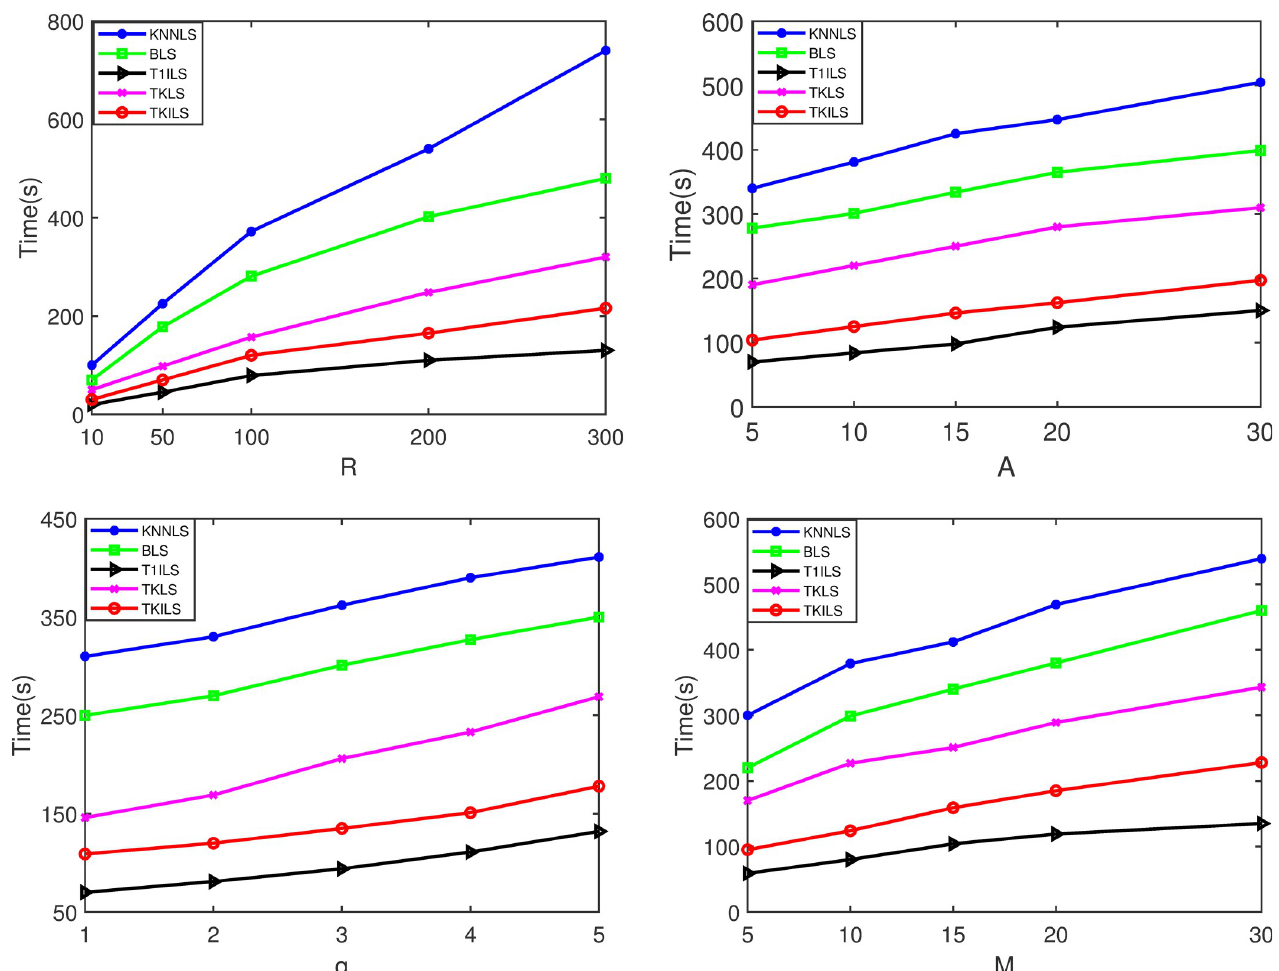
Fig 7. Time results on the synthetic datasets. Note: Fig 7(A)–7(D) are the time results for varying | R |, | A |, | q | and | M | on the synthetic datasets, respectively.